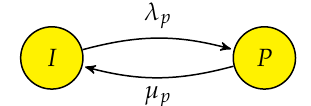
Figure 3. State Transition Diagram of